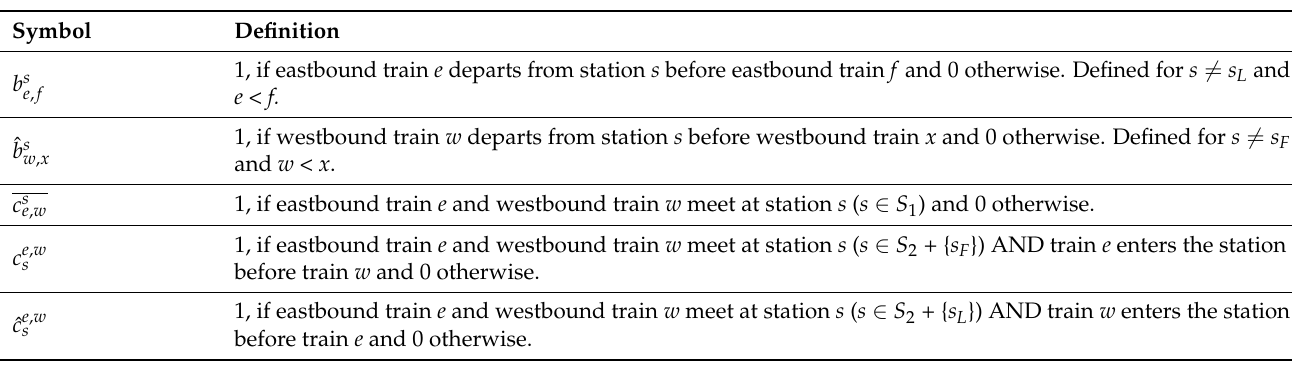
Table 5. Binary decision